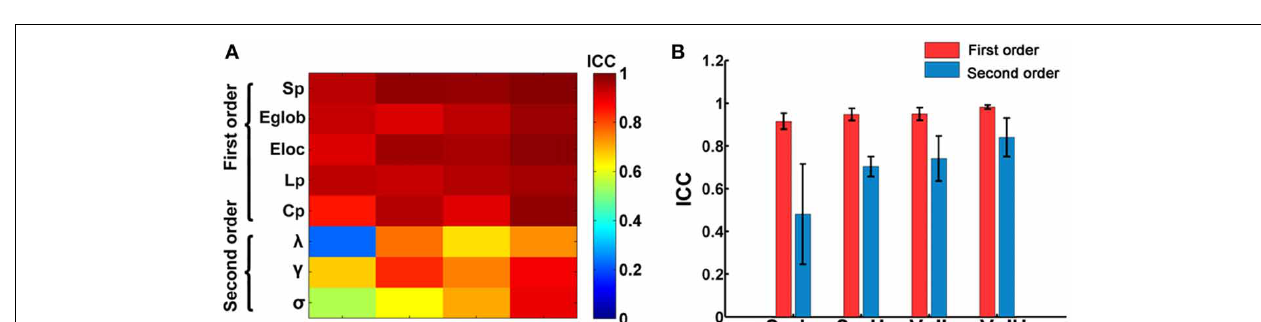
FIGURE 2 | The TRT reliability of global network properties. (A) The ICC values of global network metrics from low to high were presented with colorbars from blue to red. Multiple network metrics showed moderate to high reliability regardless of construction procedures. (B) Statistical analysis